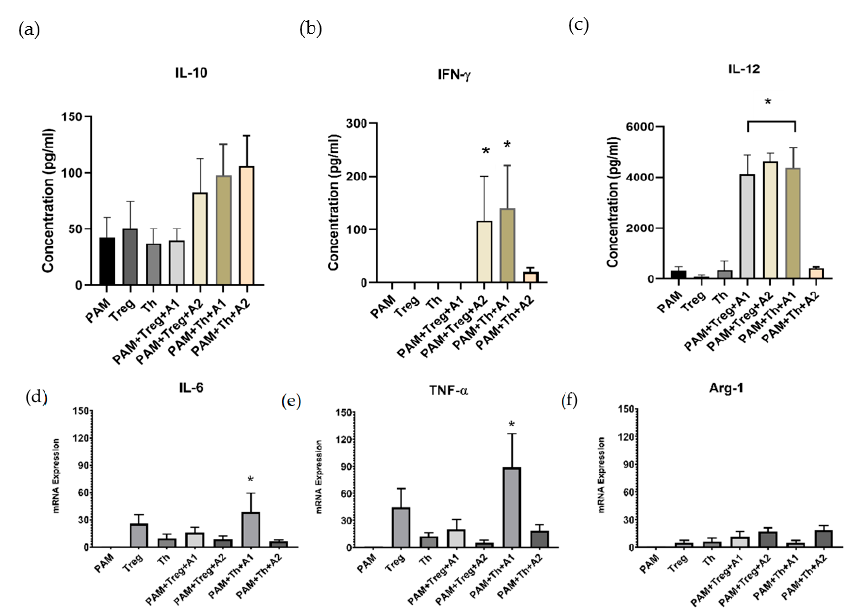
Figure 6. PAMs induced by A1 Activate Th1 cells. The conditioned medium was collected from PAMs on 48h post-challenge and analyzed by ELISA to determine cytokine levels: ( a ) IL-10, ( b ) IFN- γ , ( c ) IL-12. Each bar represents the number of cytokines secreted by individual samples . Pro-in- flammatory gene expression determined by real-time PCR. The genes profile of ( d ) IL-6 , ( e ) TNF- α were up-regulated by challenge with A1, but no any significant at ( f ) Arg-1 . Isolated PAMs were challenged with antigens followed by co-cultured with CD4 + CD25 + Tregs or CD4 + CD25 - Th1 cells for 48h. Protein concentrations were measured by ELISA and determined by mean ± SEM, calcu- lated from 3 pigs (duplicate each pig), * p < 0.05 compared to PAMs group.